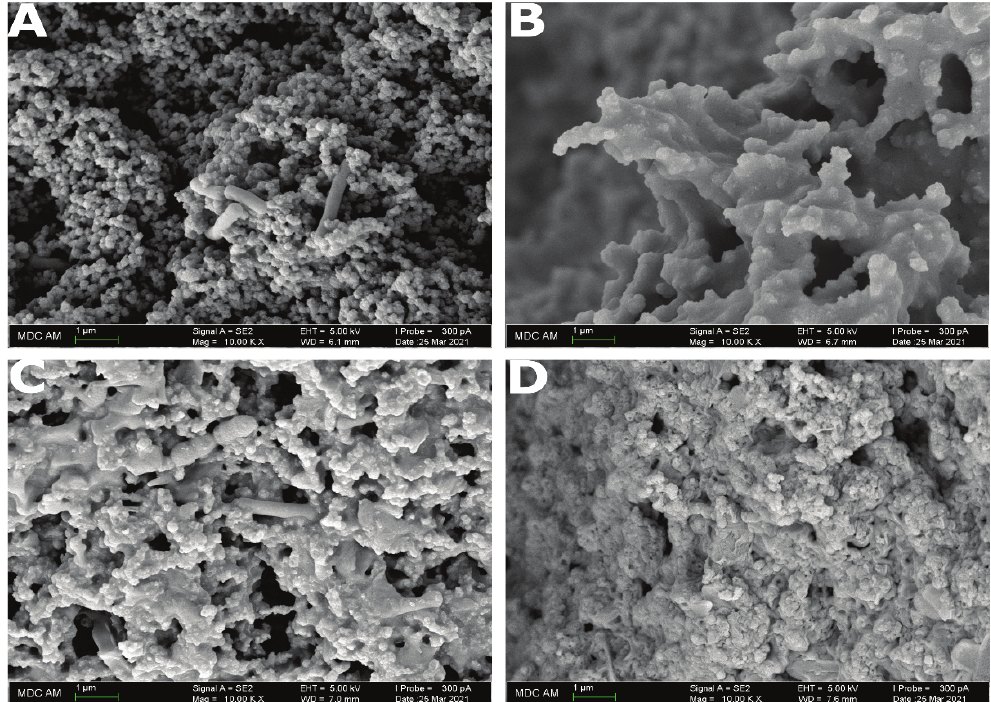
Figure 3. SEM images of fermented milk after 7 days of storage. ( A ) Skimmed milk fermented by L. bulgaricus ; ( B ) skimmed milk fermented by L. plantarum AG10; ( C ) whole milk fermented by L. bul- garicus ; ( D ) whole milk fermented by L. plantarum AG10.